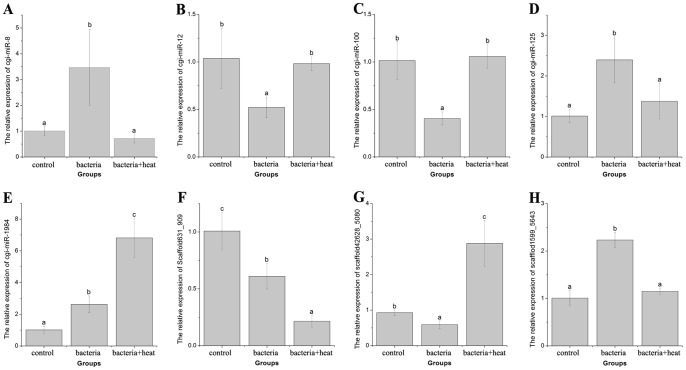
The expression of eight miRNAs detected by SYBR Green real-time PCR in oyster haemocytes after bacteria challenge and heat stress, including cgi-miR-8 (A), cgi-miR-12 (B), cgi-miR-100 (C), cgi-miR-125 (D), cgi-miR-1984 (E), scaffold631_909 (F), scaffold42648_5080 (G) and scaffold1599_5643 (H).5S gene was used as an internal control to calibrate the cDNA template for all the samples. Each values were shown as mean ± SD (N = 5), and bars with different letters were significantly different (P<0.05).